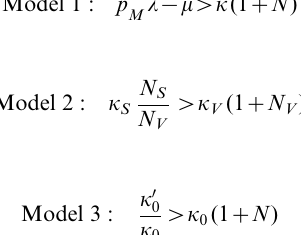
Figure 3. The Zeroth Model cannot produce RFI curves that have a maximum in the relapse rate. These inequalities are more likely to be satisfied as k or N (Model 1), k V or N V (Model 2), k 0 or N (Model 3) decrease. Therefore, each model indicates that therapies administered upon resection which either (a) induce a period of growth restriction of metastases or (b) eliminate micrometastases that require just one random growth event to escape from